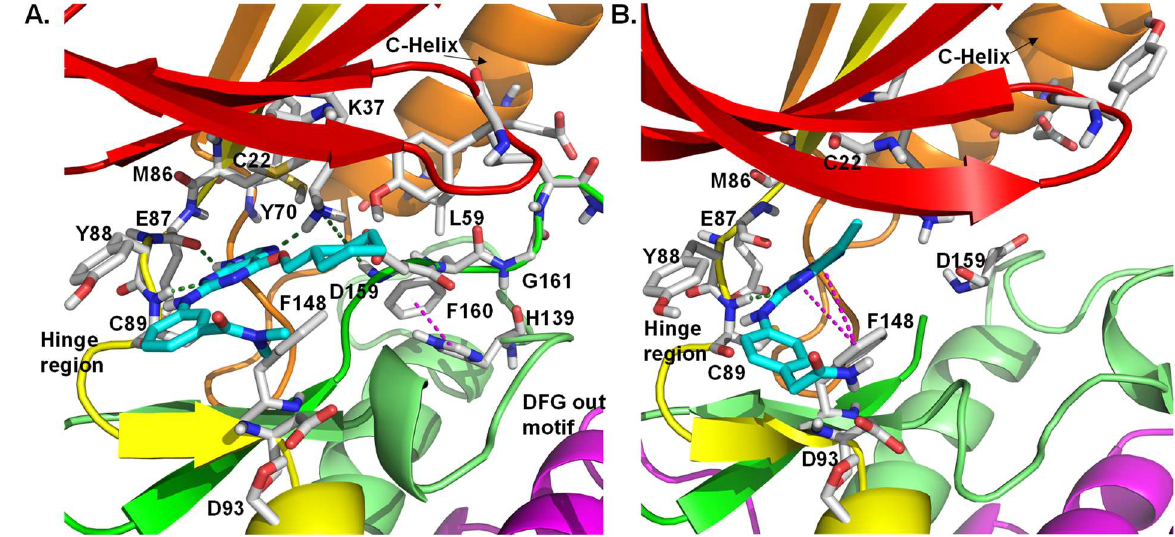
Figure 12. ( A ) Crystal structure of the purine inhibitor, compound 12a bound to T175A Nek2 kinase. The R-spine forming residues—Tyr70, Leu59, Phe160, and His139—are shown in magenta. Pi stacking interaction between Phe160 and His139 is shown by the dotted line (magenta). Inhibitor engages in H-bonding interaction (dotted green) with the hinge region (orange ribbon) in addition to Lys39 (blue) which further interacts with Asp159 (blue) of DFG. (PDB code: 5M53) ( B ) Crystal structure of compound 13 bound to Nek2 kinase. Cys22 makes a covalent bond with the alkyne group, whereas the purine ring occupies the ATP-binding site and forms H-bonding with the hinge region (shown as a green dotted line) in addition to the pi-stacking interaction that it experiences from Phe148 (shown as a magenta dotted line). (PDB code: 6SGH).